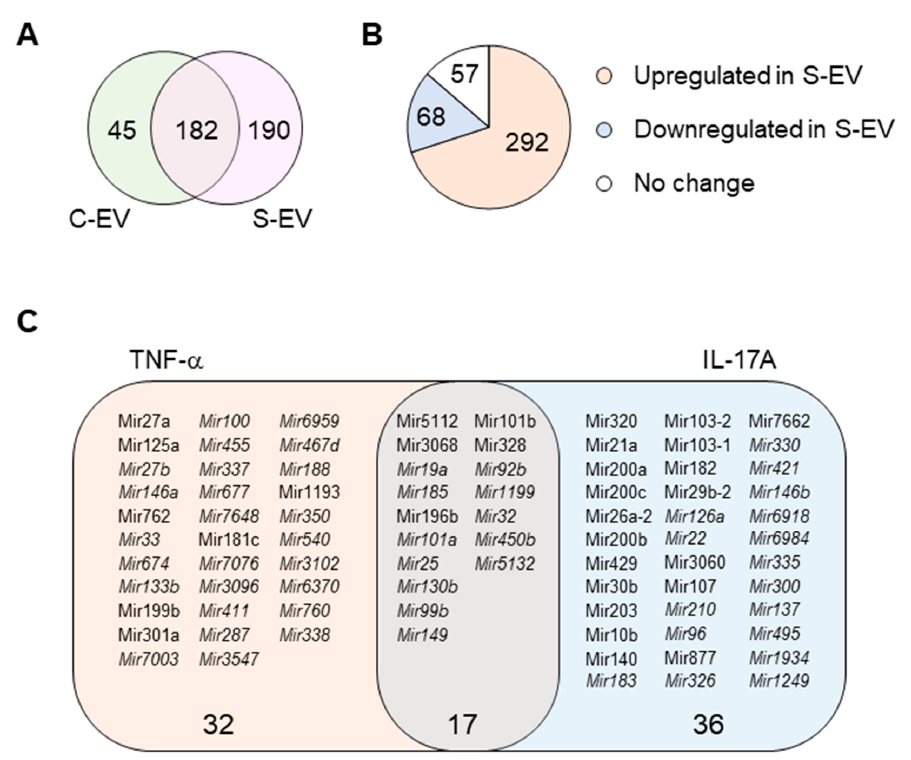
Figure 3. miRNA profiling of gut luminal EVs. ( A ) Venn diagram of microRNA distribution in control and septic gut luminal EVs. ( B ) Pie chart of di ff erential expression of gut luminal EV microRNAs based on fold-change (S-EV / C-EV) in miRNA RPKM values. ( C ) TNF- α - and IL-17A-targeting miRNAs among all the sepsis-upregulated miRNAs. The miRNAs upregulated during sepsis indicate those which showed more than a two-fold increase in RPKM values in S-EV compared with C-EV. All miRNAs were chosen based on a criteria of > 1 RPKM value. The miRNAs detected only in S-EVs are in italic. S-EV, sepsis EVs; and C-EV, control EVs. Using a TargetScan bioinfomatics analysis that concentrated on miRNAs upregulated in the intestinal epithelial EVs during sepsis, we examined those miRNAs predicted to target TNF- α , and